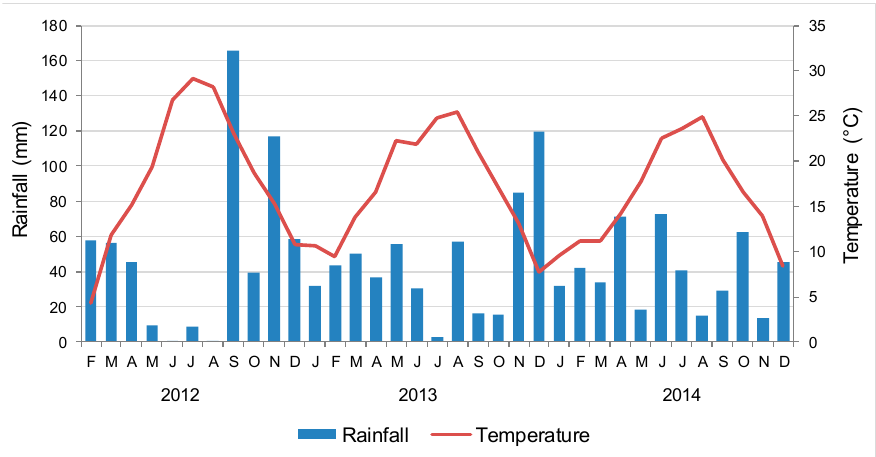
Figure 1. The trend of total rainfall and mean temperature between February 2012 and December 2014 in the investigated area.